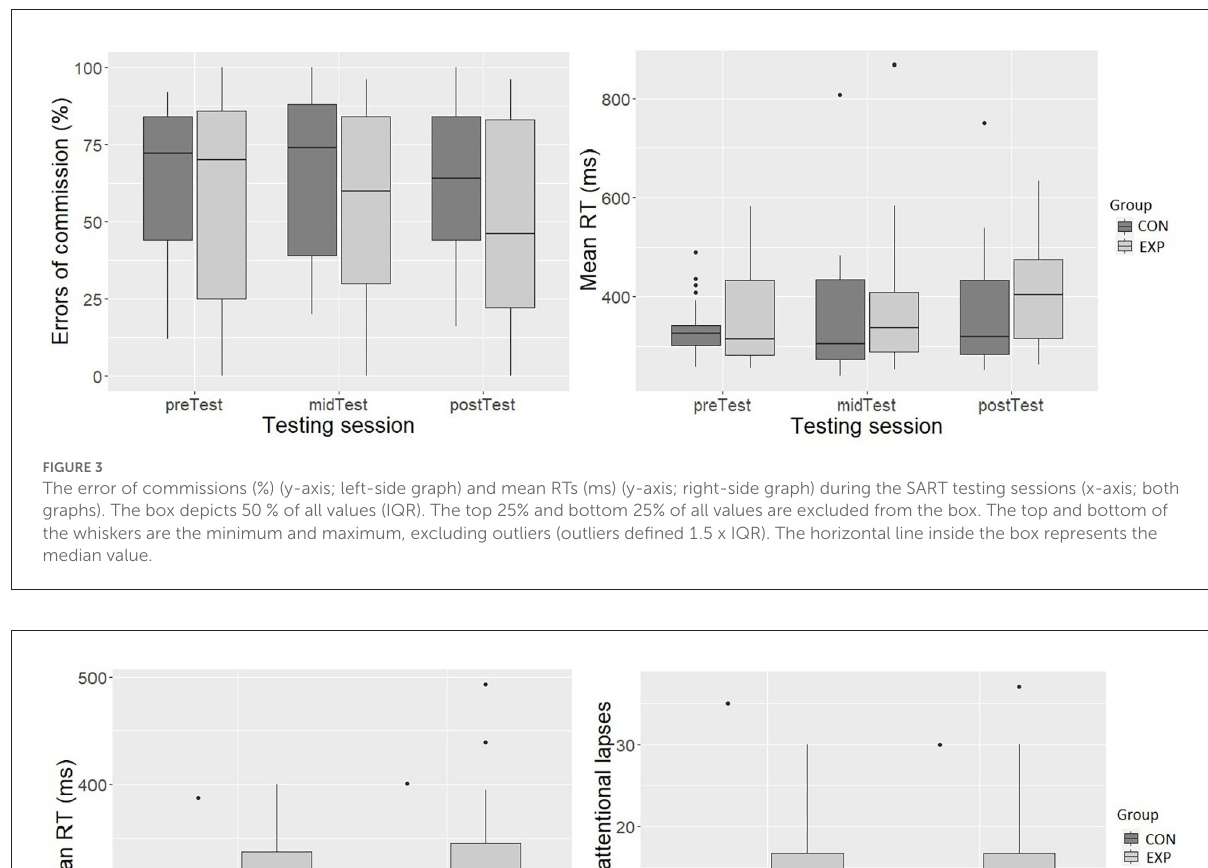
RMSSD during the